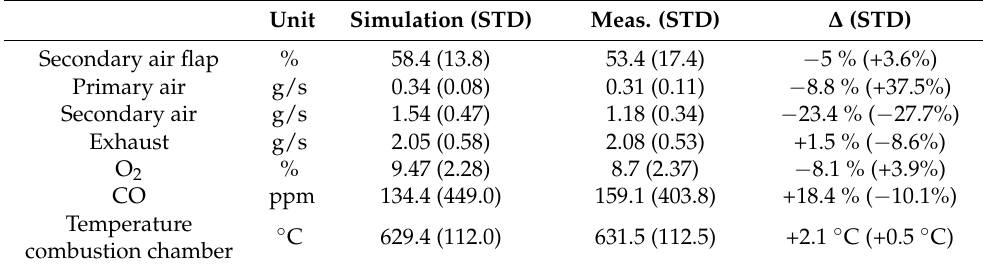
Table 3. Averaged values of the comparison between load cycle test and simulation results including the standard deviation (std).